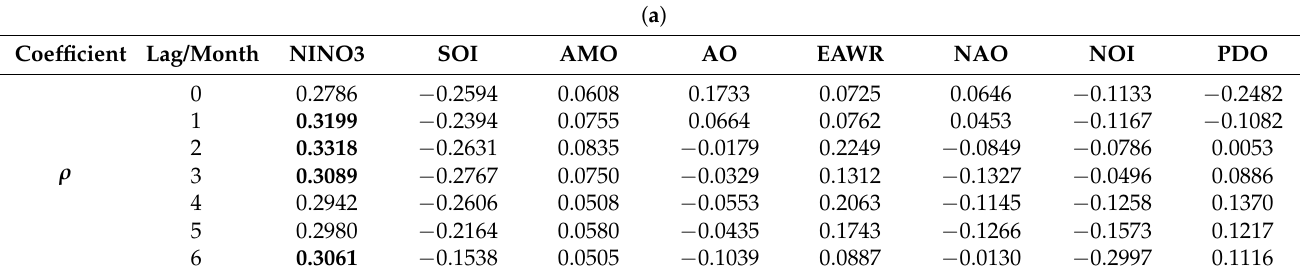
Table A4. The Pearson correlation coefficient ρ and the Kendall correlation coefficient τ between the time series of precipitation in spring ( a ) and autumn ( b ) and climate indices under lags from 0- to 6- month. Bold means statistically significant at the level of